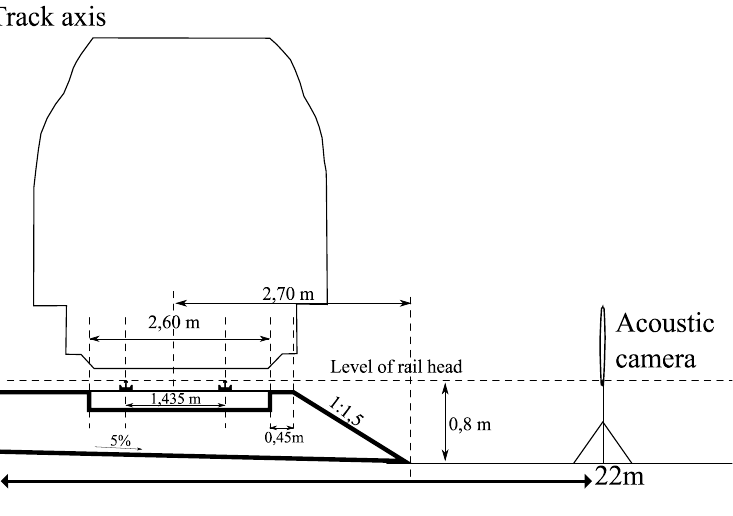
Figure 6. Instrumented cross-section Turing experimental tests.